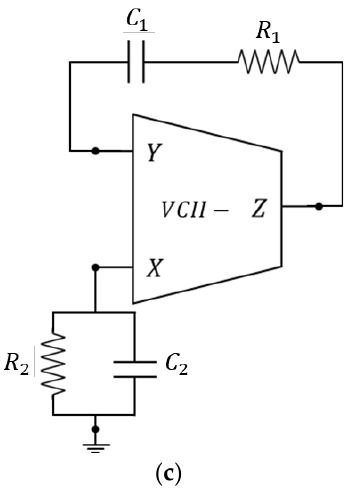
Figure 9. Two different CCII-based proposed interfaces using a square-wave generator for resistive and capacitive sensors: ( a ) the square-wave generator proposed in [53]; ( b ) the square-wave generator proposed in [84]; ( c ) the sine-wave oscillator proposed in [34].